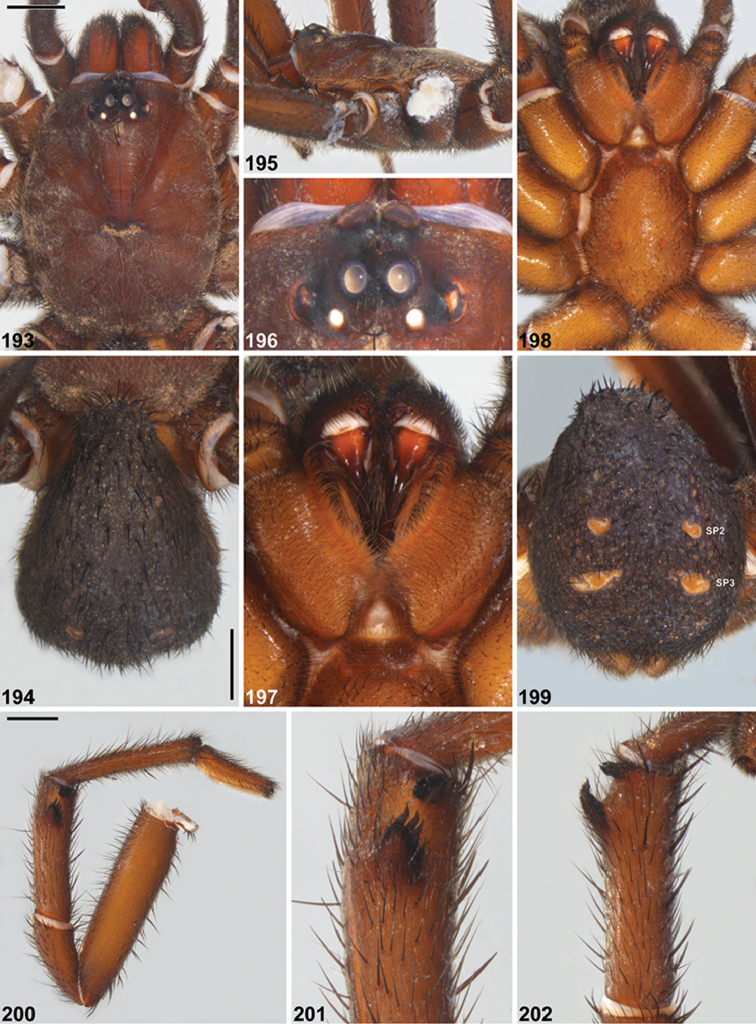

Idiosoma
incomptum sp. n., male holotype (WAM T99997) from Carnarvon (Western Australia; CAR), somatic morphology. 193–194 Carapace and abdomen, dorsal view 195 Carapace, lateral view 196 Eyes, dorsal view 197 Mouthparts, ventral view 198 Sternum, ventral view 199 Abdomen, posterior view 200 Leg I, prolateral view 201 Leg I tibia, clasping spurs, prolateral view 202 Leg I tibia, proventral view. Scale bars 2.0. SP2–3 = sigilla pairs 2–3.